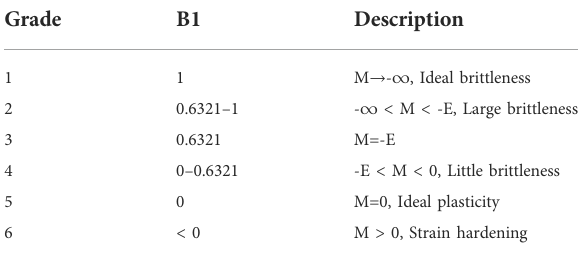
TABLE 3 Classi fi cation and description of brittleness index B1 (Liu & Shen,